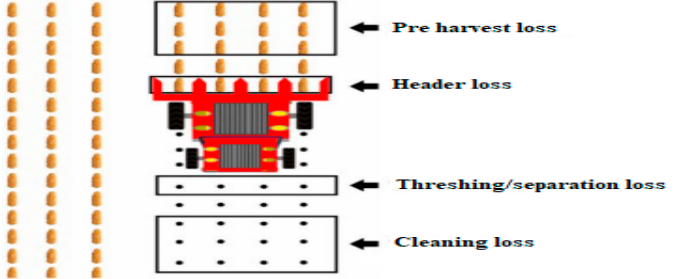
Figure 7. Measurement methods of grain harvest loss [16].